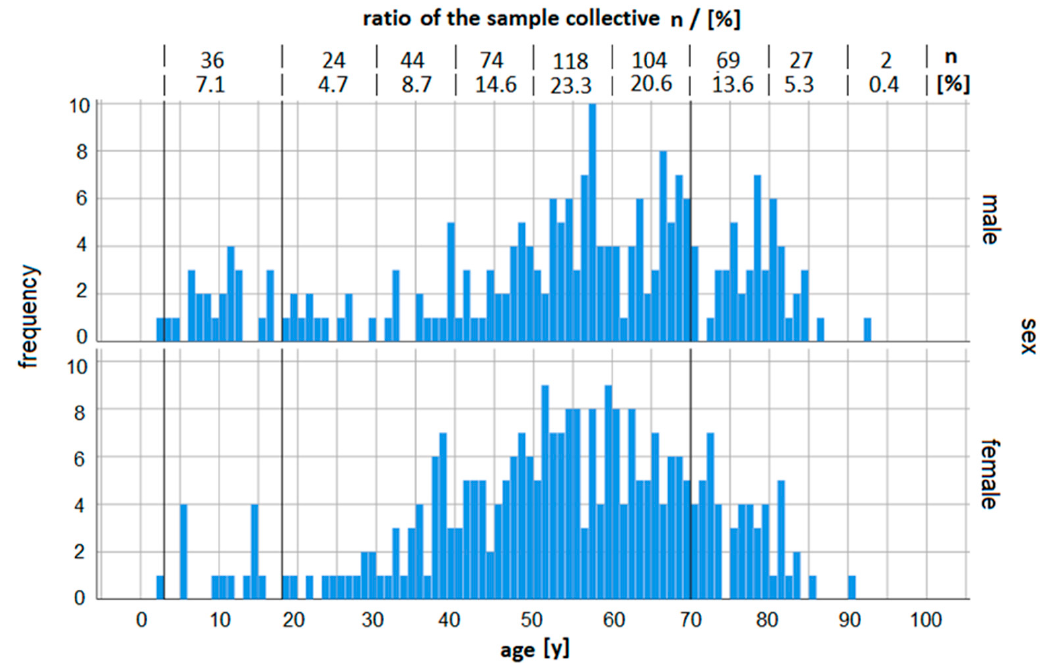
Figure 2. Age distribution of the participants depending on sex. Vertical lines indicate 3 years, 18 years, and 70 years. RV exist for 3 to 17-year-old persons and 18 to 70-year-old persons, only.